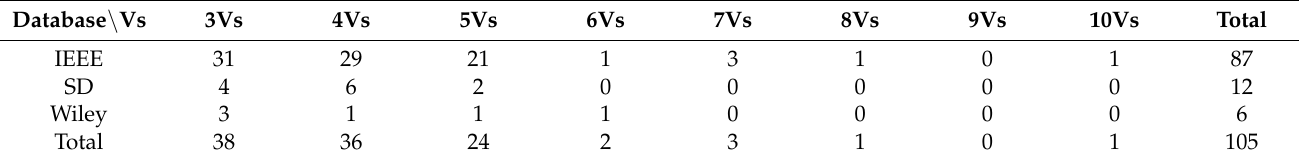
Table 2. Number of articles about Big Data and the ‘Vs’ in different